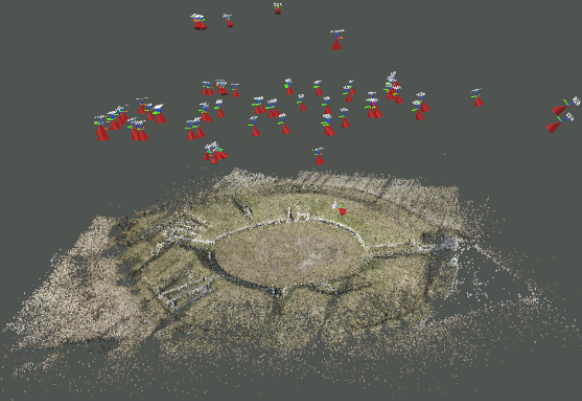
Figure 1: Relatively oriented UPs with reconstructed sparse point cloud in model space, computed by matching the statistical de- scriptions of local neighbourhoods of scale-invariant image fea- ture